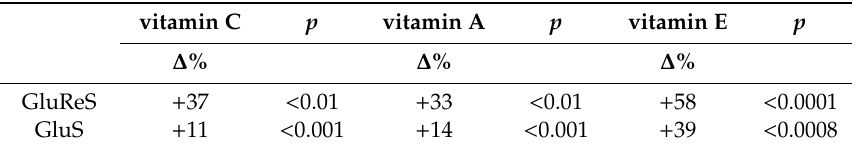
Table 4. Summary of the change from t0 to t1 ( ∆ %) and significance ( p ) of the three vitamins for the two groups. vitamin C p vitamin A